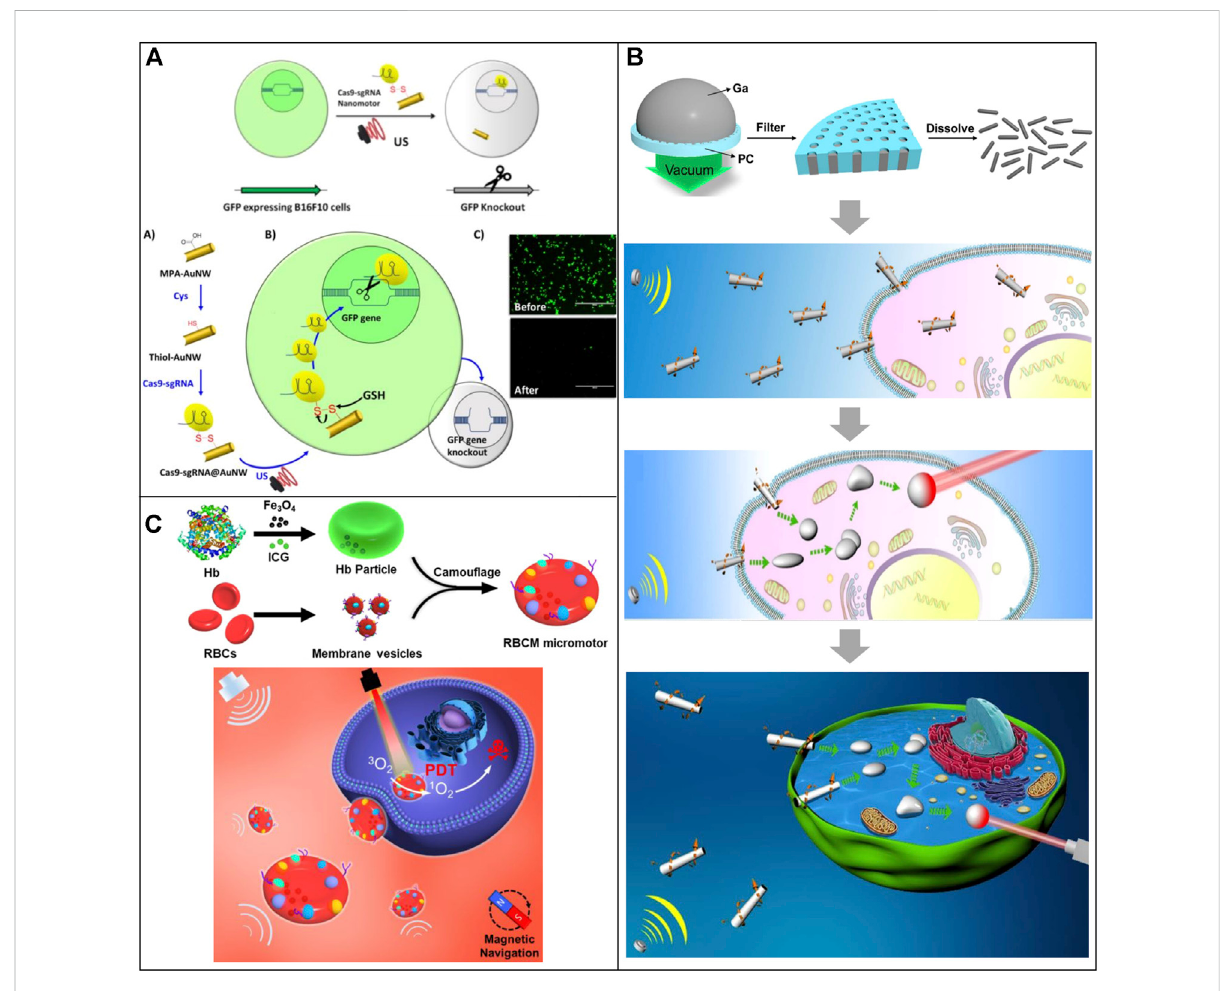
FIGURE 6 Motile drug delivery by ultrasound-powered MNRs. (A) Red blood cell mimicking-micromotor. (Hansen-Bruhn et al., 2018) Copyright 2018. Reproduced with permission from John Wiley and Sons. (B) Shape-transformable, fusible rodlike swimming liquid metal nanomachine. (Wang et al., 2018) Copyright 2018. Reproduced with permission from American Chemical Society. (C) Cas9-sgRNA@gold nanowire (AuNW) motor. (Gao et al., 2019) Copyright 2019. Reproduced with permission from American Chemical